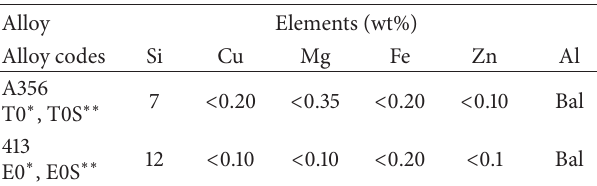
Table 1: Chemical composition of the base alloys used in the present